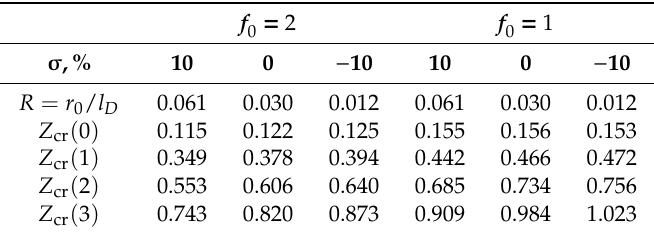
Table 1. Values of the critical charge Z cr ( n ) versus the mechanical tension σ for graphene on the h BN substrate. The data is given for the first four levels n = 0, 1, 2, 3 with the total angular momentum J = 0, and for two kinds of cuto ff function corresponding to the values f 0 = 2 and f 0 = 1, with a cuto ff radius r 0 = Rl D = 15Å.